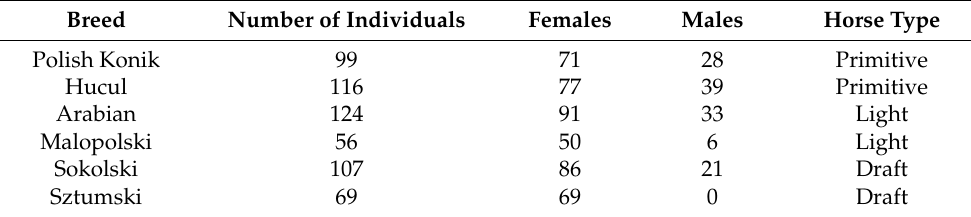
Table 1. Numbers and horse types of the studied